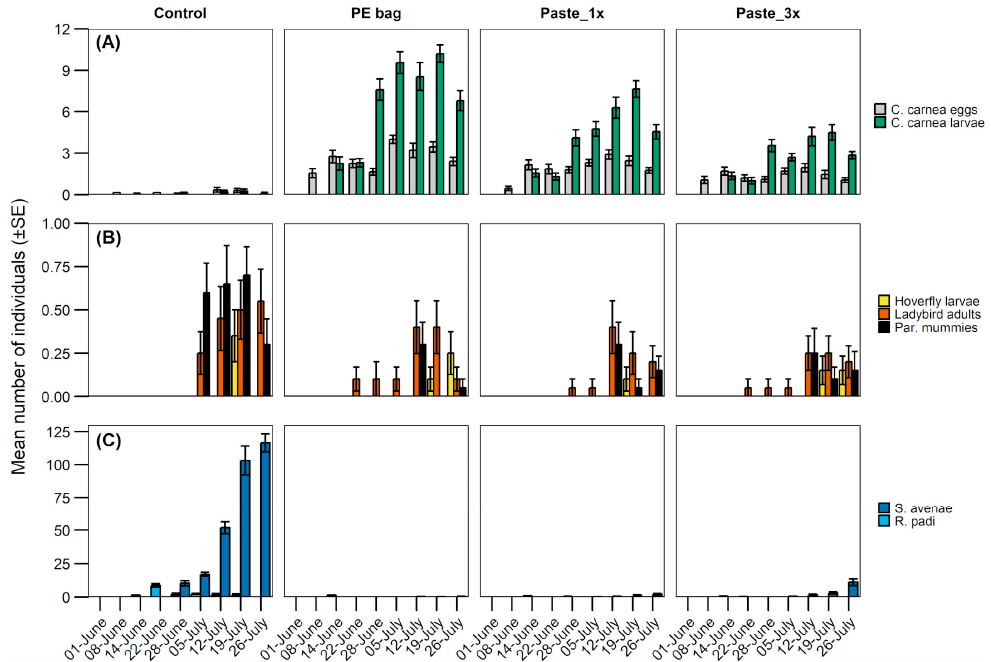
Figure 3. Mean number (±SE) of ( A ) lacewing, ( B ) other natural enemies, and ( C ) aphids observed on three barley plants during the experiment.